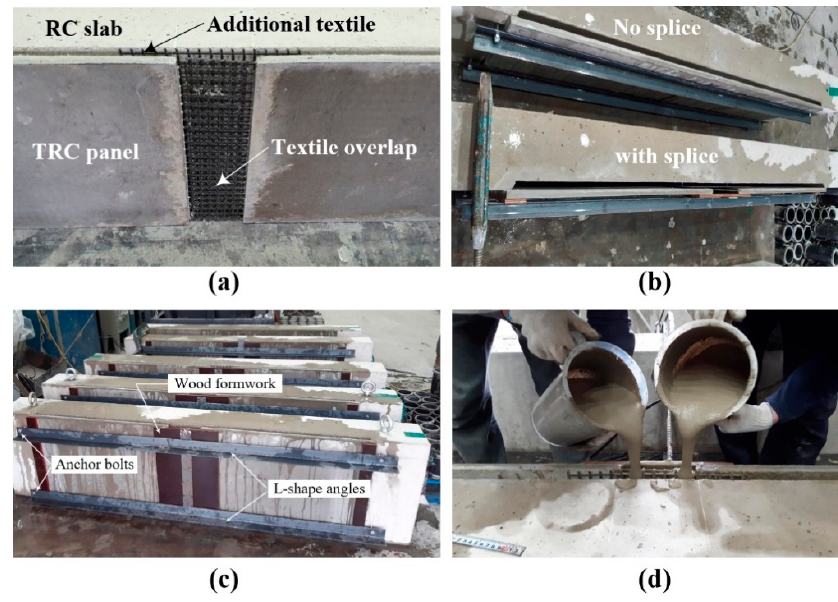
Figure 13. Strengthening process: ( a ) installation of TRC panels; ( b ) assembling of panels; ( c ) water spraying; and ( d ) grouting.